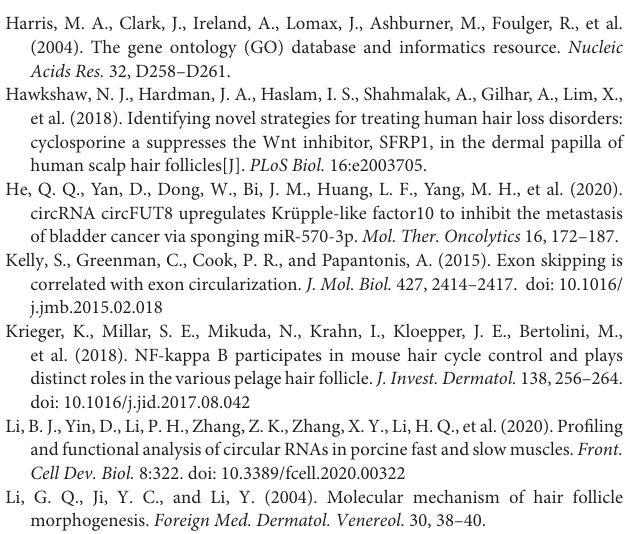
Supplementary Figure 1 | Changeable process in hair follicle morphogenesis of the Inner Mongolian cashmere goat in the fetal period. Supplementary Figure 2 | Volcano plot of all DE circRNAs in six comparison groups. Supplementary Figure 3 | GO and KEGG enrichment analysis of host genes of DE circRNAs. Supplementary Table 1 | Primer information for qRT-PCR. Supplementary Table 2 | CircRNAs verified by qRT-PCR and related